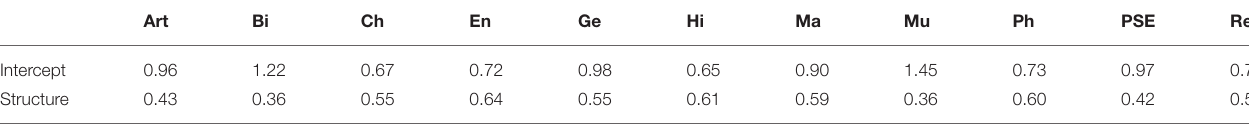
TABLE 2 | Subject-specific coefficients for the random coefficient model in Table 1 .